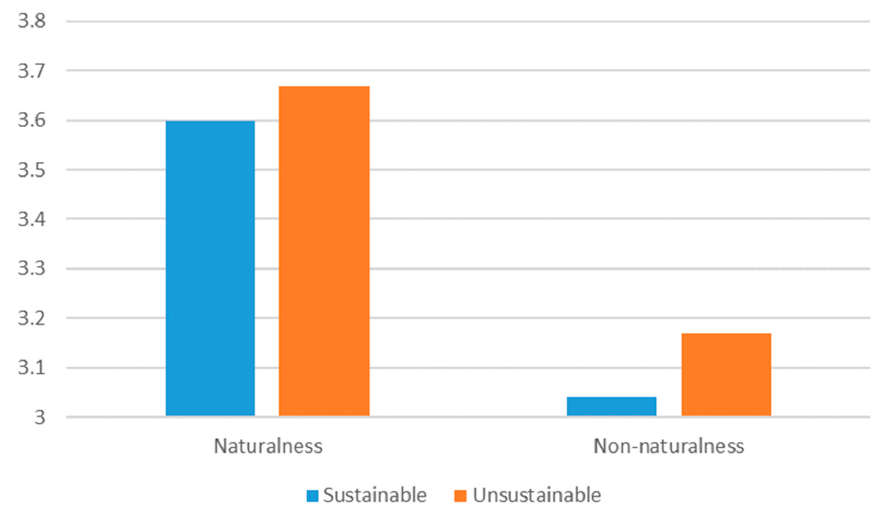
Figure 3. The effect of naturalness and sustainability on perceived aesthetics.